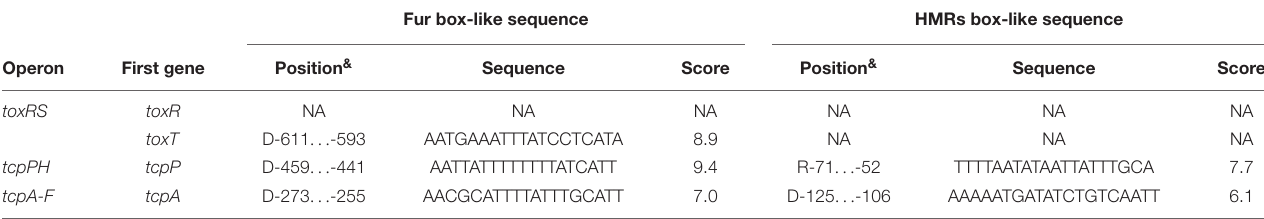
TABLE 2 | Predicted HMRs/Fur box-like sequences within target promoters. Fur box-like sequence HMRs box-like sequence